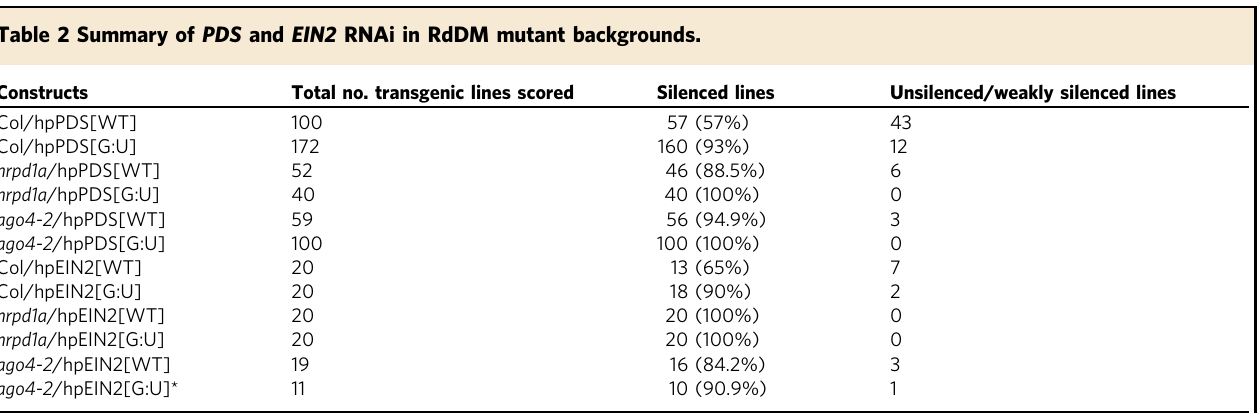
Fig. 5 The G:U modi fi ed EIN2 hpRNA transgene shows greatly diminished DNA methylation at the promoter region. a McrBC-digestion PCR of the 35S- EIN2 junctions regions (see Fig. 2b, S4a for EIN2 silencing phenotypes). b Bisul fi te sequencing of the 35S promoter-EIN2 junction region (the top strand only; the two arrows indicate the locations of the forward and reverse bisul fi te PCR primers). Note that the 140 bp EIN2 sequence in hpEIN2[G:U] has no cytosines in the top strand so the low levels of signals re fl ect the background cytosine noises in the sequencing trace fi les. c Box plot (R version 3.6.0) showing the average cytosine methylation levels of the 35S promoter region in ( b ). The central horizontal line indicates the median value, the lower and upper borders of the box represent the fi rst and third quartiles, and the outliers are represented by dots. d – f The hpPDS[WT] transgene shows stronger 35S promoter methylation in true leaves than in cotyledons. d , e McrBC-digestion PCR and qPCR of primary T1 transgenic lines. Primary T1 lines were randomly divided into two pools (I and II) and photo-bleached cotyledons from multiple T1 transgenic plants within each pool were collected and combined to generate two DNA samples. Young leaf tissues were also harvested from the same two groups but were divided into four pools (two pools for each of the two cotyledon pools) (Ia, Ib, and IIa, IIb). f McrBC-digestion qPCR of T2 transgenic plants. As T1 plants with strong PDS RNAi did not grow to seed, only two lines each with moderate PDS RNAi were analyzed. For each of the four lines, photobleached cotyledons and the fi rst true leaves that had just emerged were harvested from ~25 T2 progeny, and used for DNA extraction and McrBC-digestion qPCR analysis. For qPCR in ( e ) and ( f ), three technical replicates were measured for each sample, and data are presented as mean values ± s.d. with the three data points shown as grey dots. Source data are provided as a Source Data fi le.